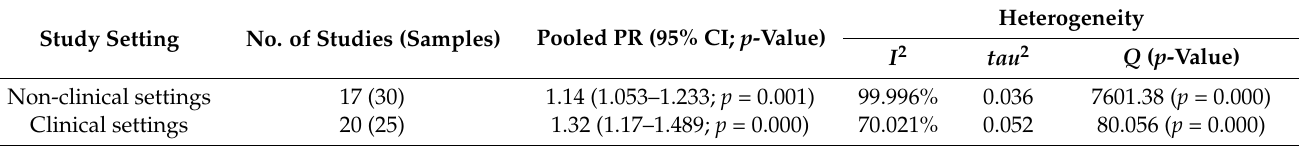
Table 5. Summary of meta-analysis results for studies reporting suicide attempt in non-clinical and clinical